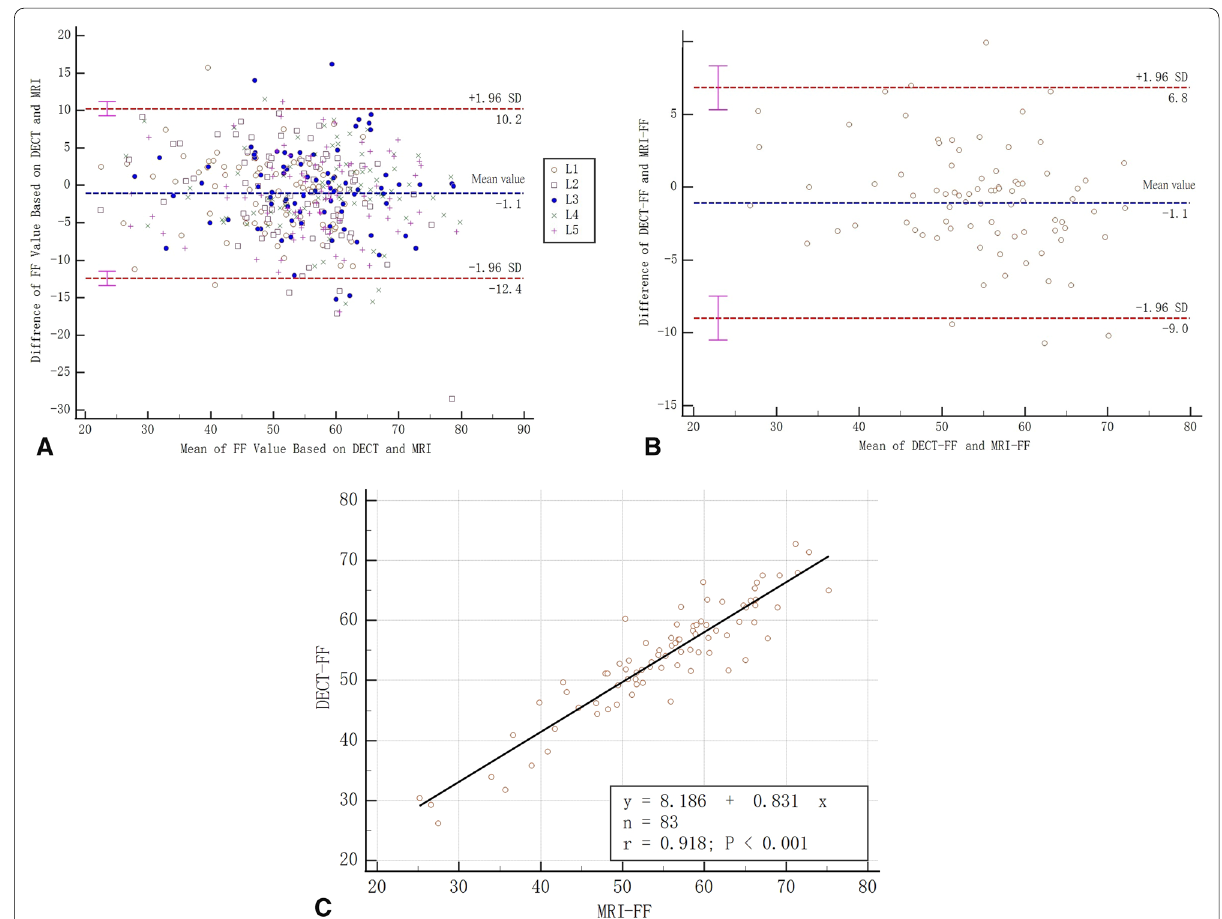
Fig. 4 Bland–Altman plots for the agreement between EDCT and MRI. A The agreement between the FF values of all 415 vertebrae based on EDCT and MRI. B Bland–Altman plots for the agreement between the FF values of all 83 parents based on EDCT and MRI. C DECT-FF and MRI-FF were linearly correlated, with a slope of 0.831 and an intercept of 8.186. DECT: Dual-energy computed tomography, MRI: magnetic resonance imaging, FF: fat fraction